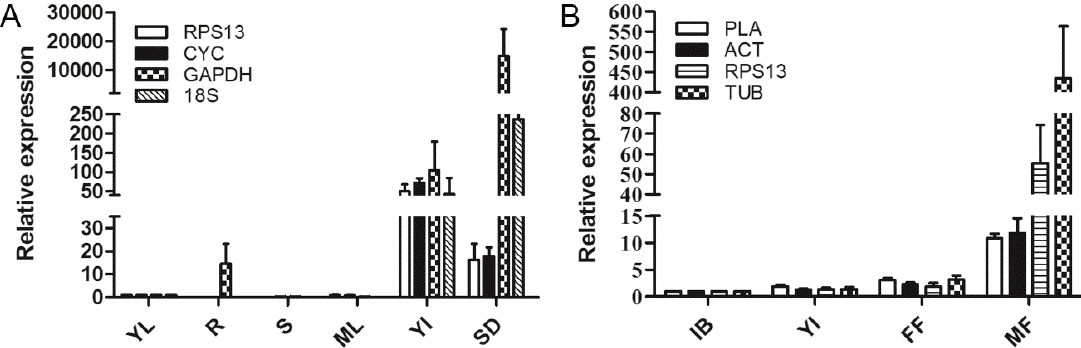
Figure 3. Relative quantification of the AGAMOUS homolog ( PvoAG ) in Sacha inchi using the validated reference genes for normalization. ( A ) PvoAG expression pattern in adult plants. The four kinds of bars indicate PvoAG expression levels normalized by different reference genes RPS13 , CYC , GAPDH and 18S respectively; and ( B ) PvoAG expression pattern during flower development. The four kinds of bars indicate PvoAG expression levels normalized by different reference genes PLA , ACT , RPS13 and TUB respectively. YL, young leaf; R, root; S, stem; ML, mature leaf; YI, young inflorescence; SD, seed (90 DAP); IB, inflorescence bud; FF, female flower; MF, male